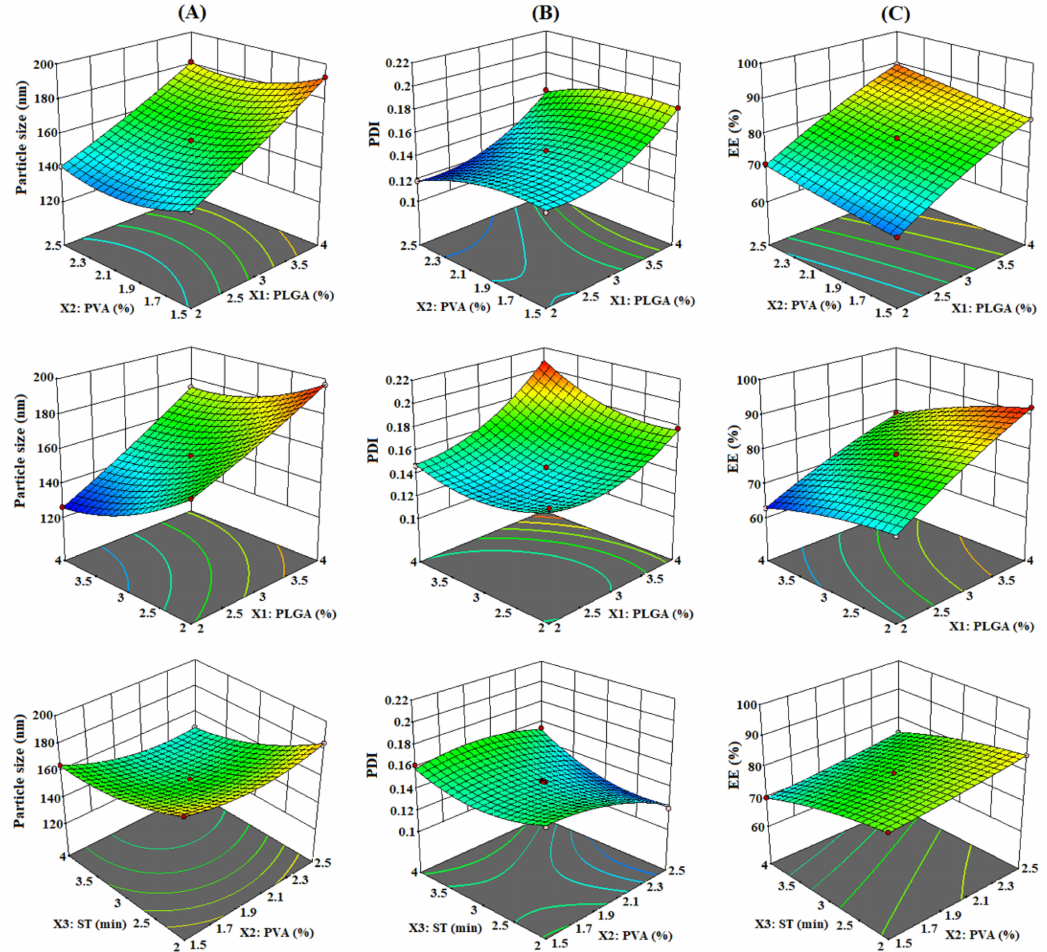
Figure 1. Response surface plots showing the influence of PLGA ( X 1 ), PVA ( X 2 ), and ST ( X 3 ) on response parameters: ( A ) PS ( Y 1 ), ( B ) PDI ( Y 2 ), and ( C) . EE ( Y 3 ) of